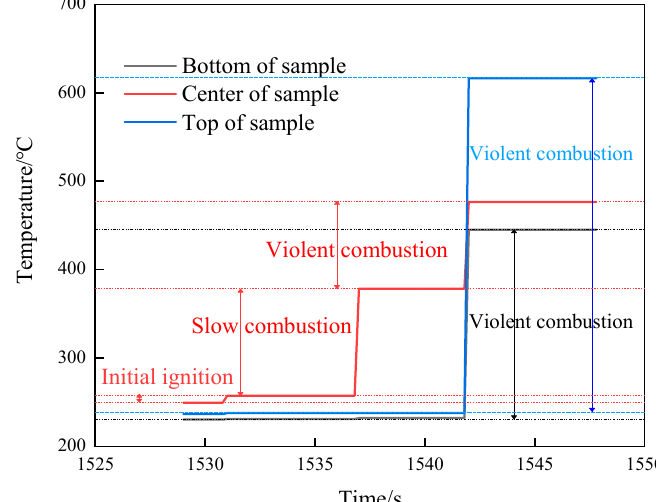
Figure 6. Temperature–time curve of shot 1.